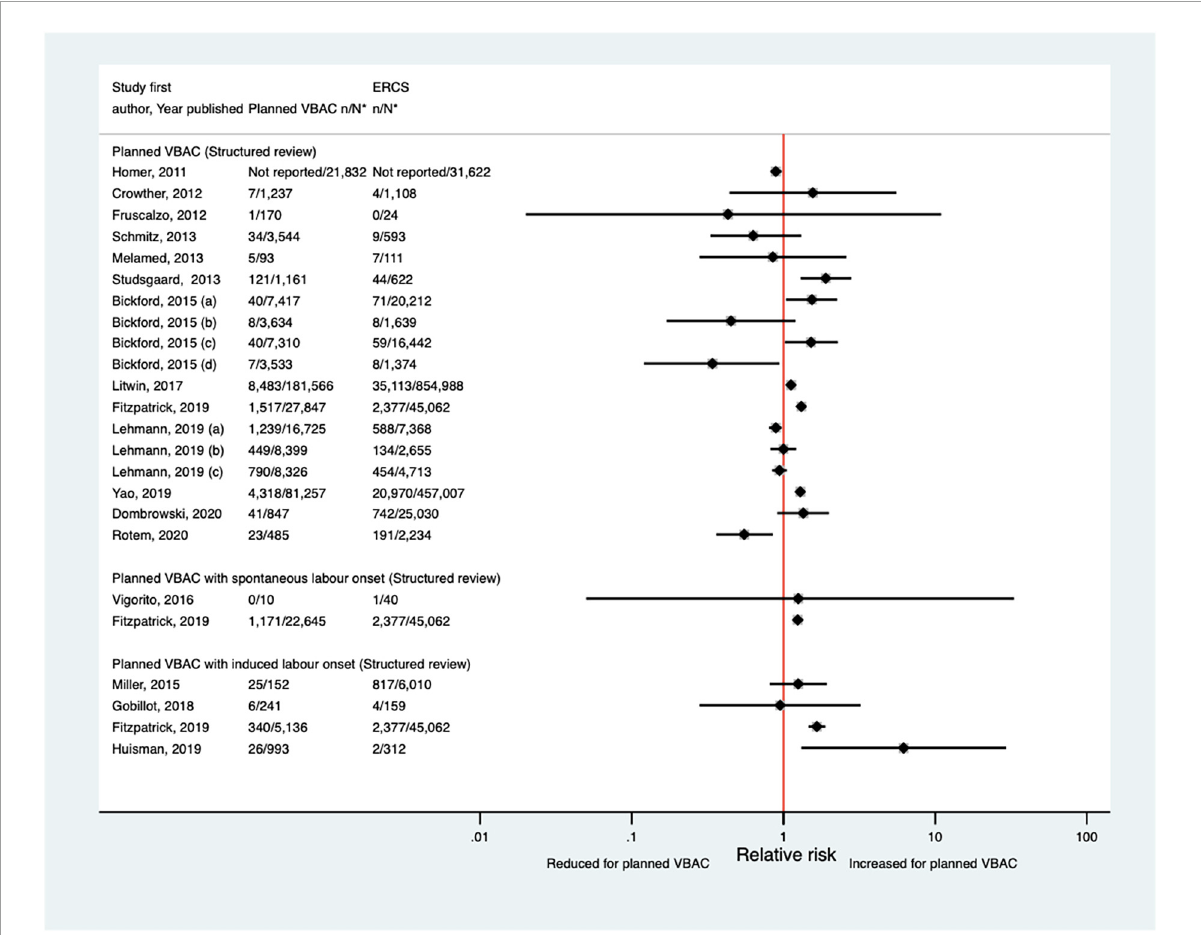
FIGURE13 Risk of NICU admission for planned VBAC vs. ERCS. * n , number in group with the outcome; N , Total number in group. Bickford and Janssen (50) (a) risk in women with 1–2 prior CSs only, (b) risk in women with 1–2 prior CSs and ≥ 1 prior VB, (c) risk in women with 1 prior CS only, (d) risk in women with 1 prior CS and ≥ 1 prior VB; Lehmann et al. (67) (a) risk in all of study population, (b) risk in “low-risk” women, (c) risk in “high-risk” women. CS, cesarean section; ERCS, elective repeat cesarean section; NICU, neonatal intensive care unit; VBAC, vaginal birth after previous cesarean; VB, vaginal